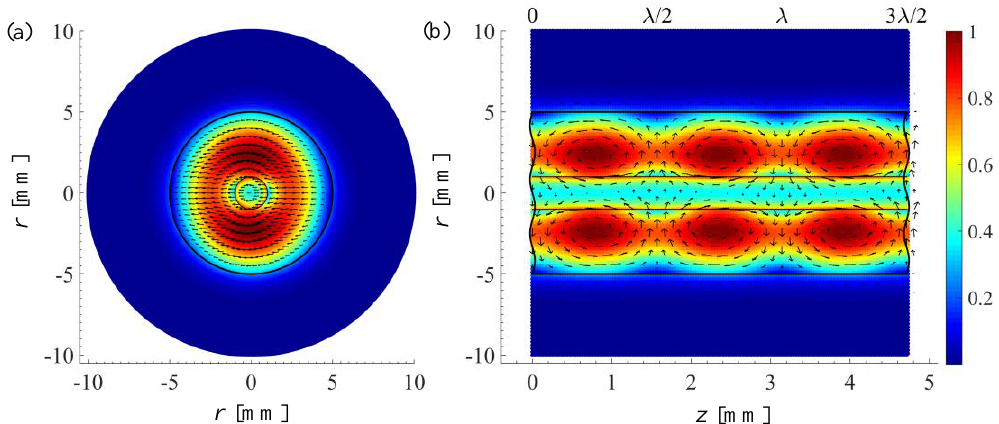
Figure 6. Transverse ( a ) and longitudinal ( b ) electric field distributions of the fundamental mode in empty glass tube waveguide at frequency of 50 GHz.